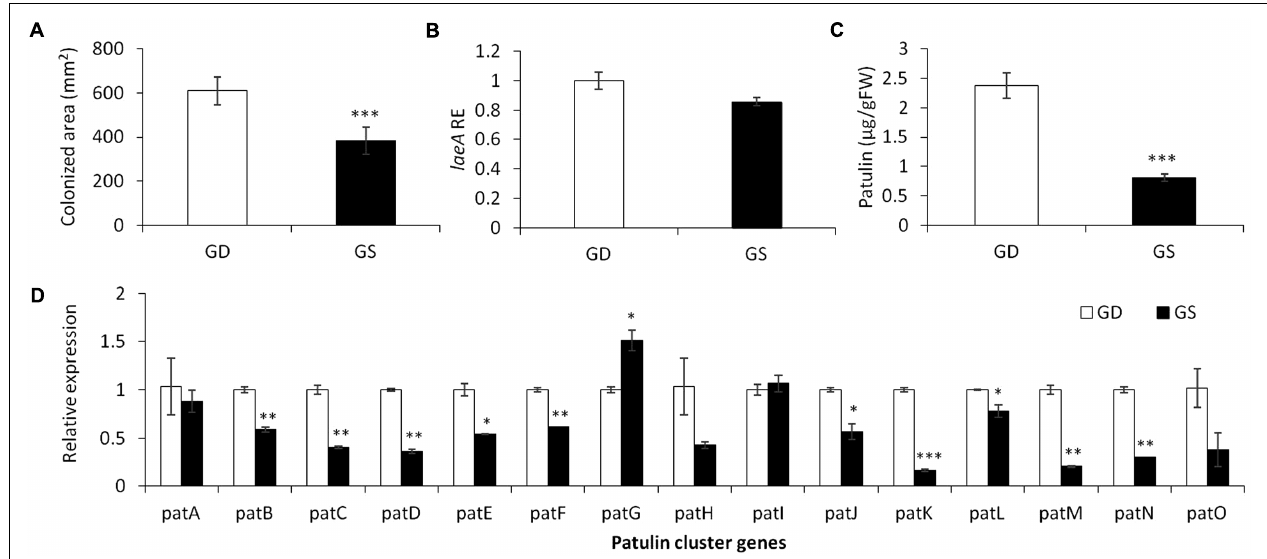
FIGURE 2 | Effect of differential response of two apple cultivars, Golden Delicious (GD) and Granny Smith (GS) on the relative expression of laeA and patulin cluster, patulin accumulation, and colonized surface following the inoculation of P. expansum . Apple fruits were sampled from storage at 0 ◦ C and inoculated immediately. Five days later the colonization pattern (A) , laeA relative expression (B) , patulin accumulation in the colonized tissue (C) , and the relative expression of the pat cluster genes (PCG) (D) was evaluated. RNA was prepared from the leading edge of the colonized area. Average values ( ± SE) of five replicates are reported. For statistical analysis, the unpaired student t -test was used with significance defined as a P value ( ∗ P ≤ 0.05; ∗∗ P ≤ 0.01; ∗∗∗ P ≤ 0.001).